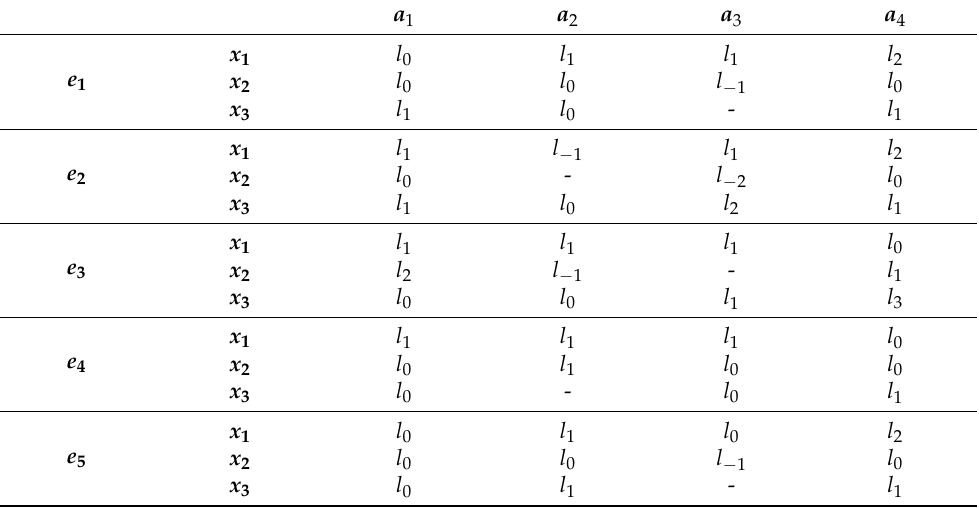
Table 1. The DMs’